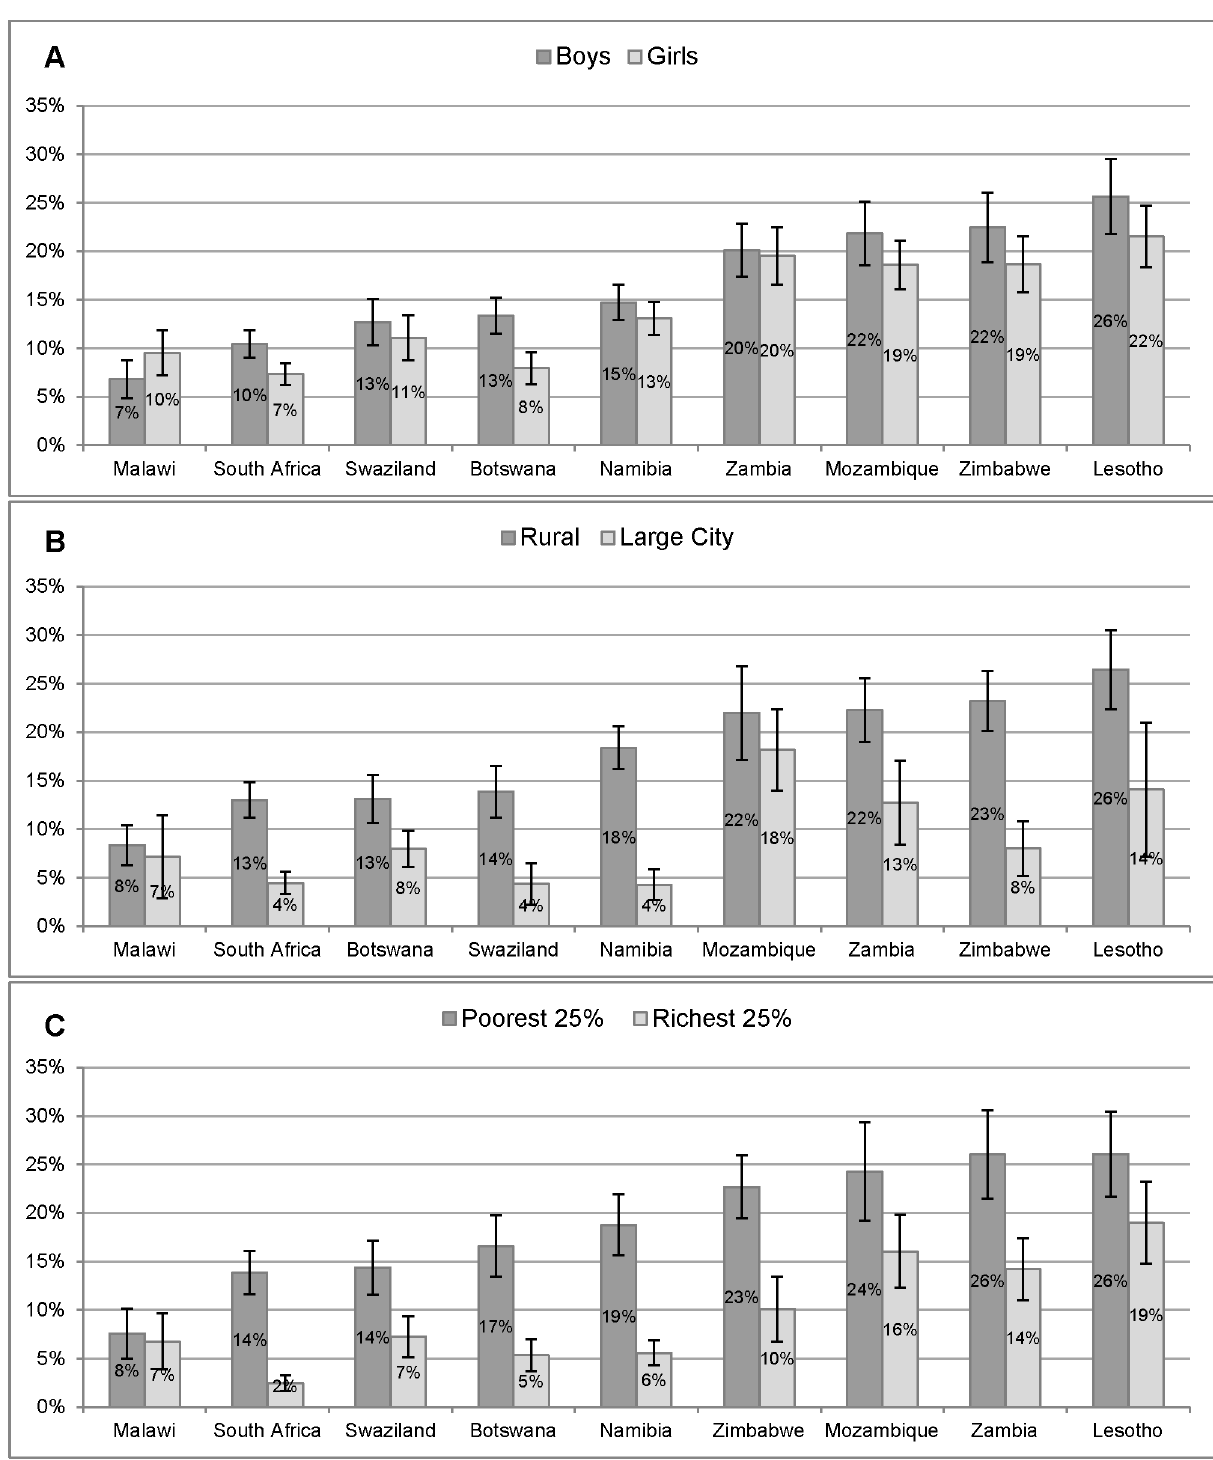
Figure 1. Response to an HIV-positive status of a close friend. Proportion of grade 6 students that would ‘‘avoid or shun’’ a close friend who revealed that they were living with HIV by gender (Figure 1A), geographic location (Figure 1B) and wealth quartile (Figure 1C) including 95% confidence interval).